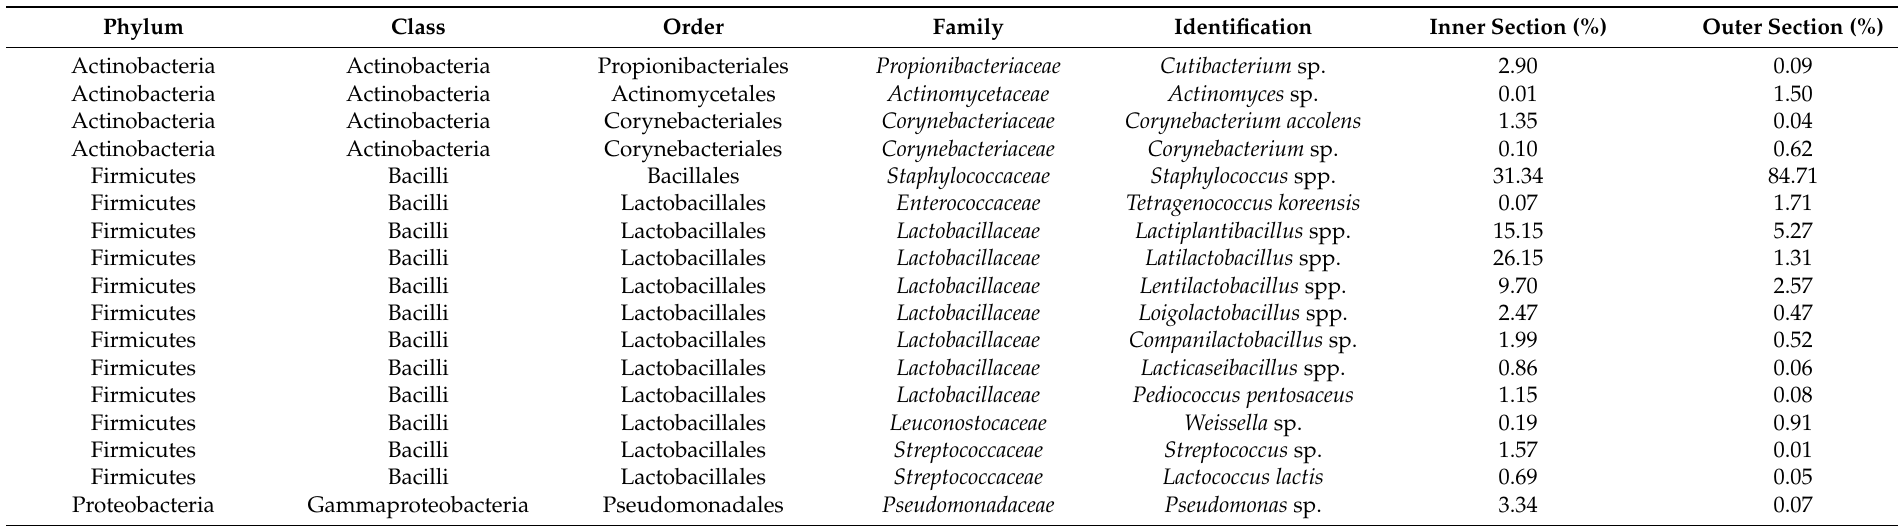
Table 2. Microbial community composition (by 16S rRNA gene V3–V4 region sequencing) of the inner and outer section of the ripened Ventricina samples. Only the amplicon sequence variants (ASVs) which reached a concentration higher than 0.5% in at least one of the samples are